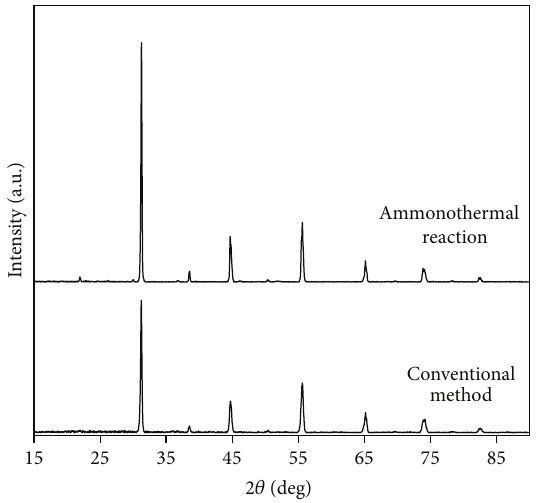
Figure 1: XRD patterns of products synthesized by the ammono- thermal method and by the conventional method.